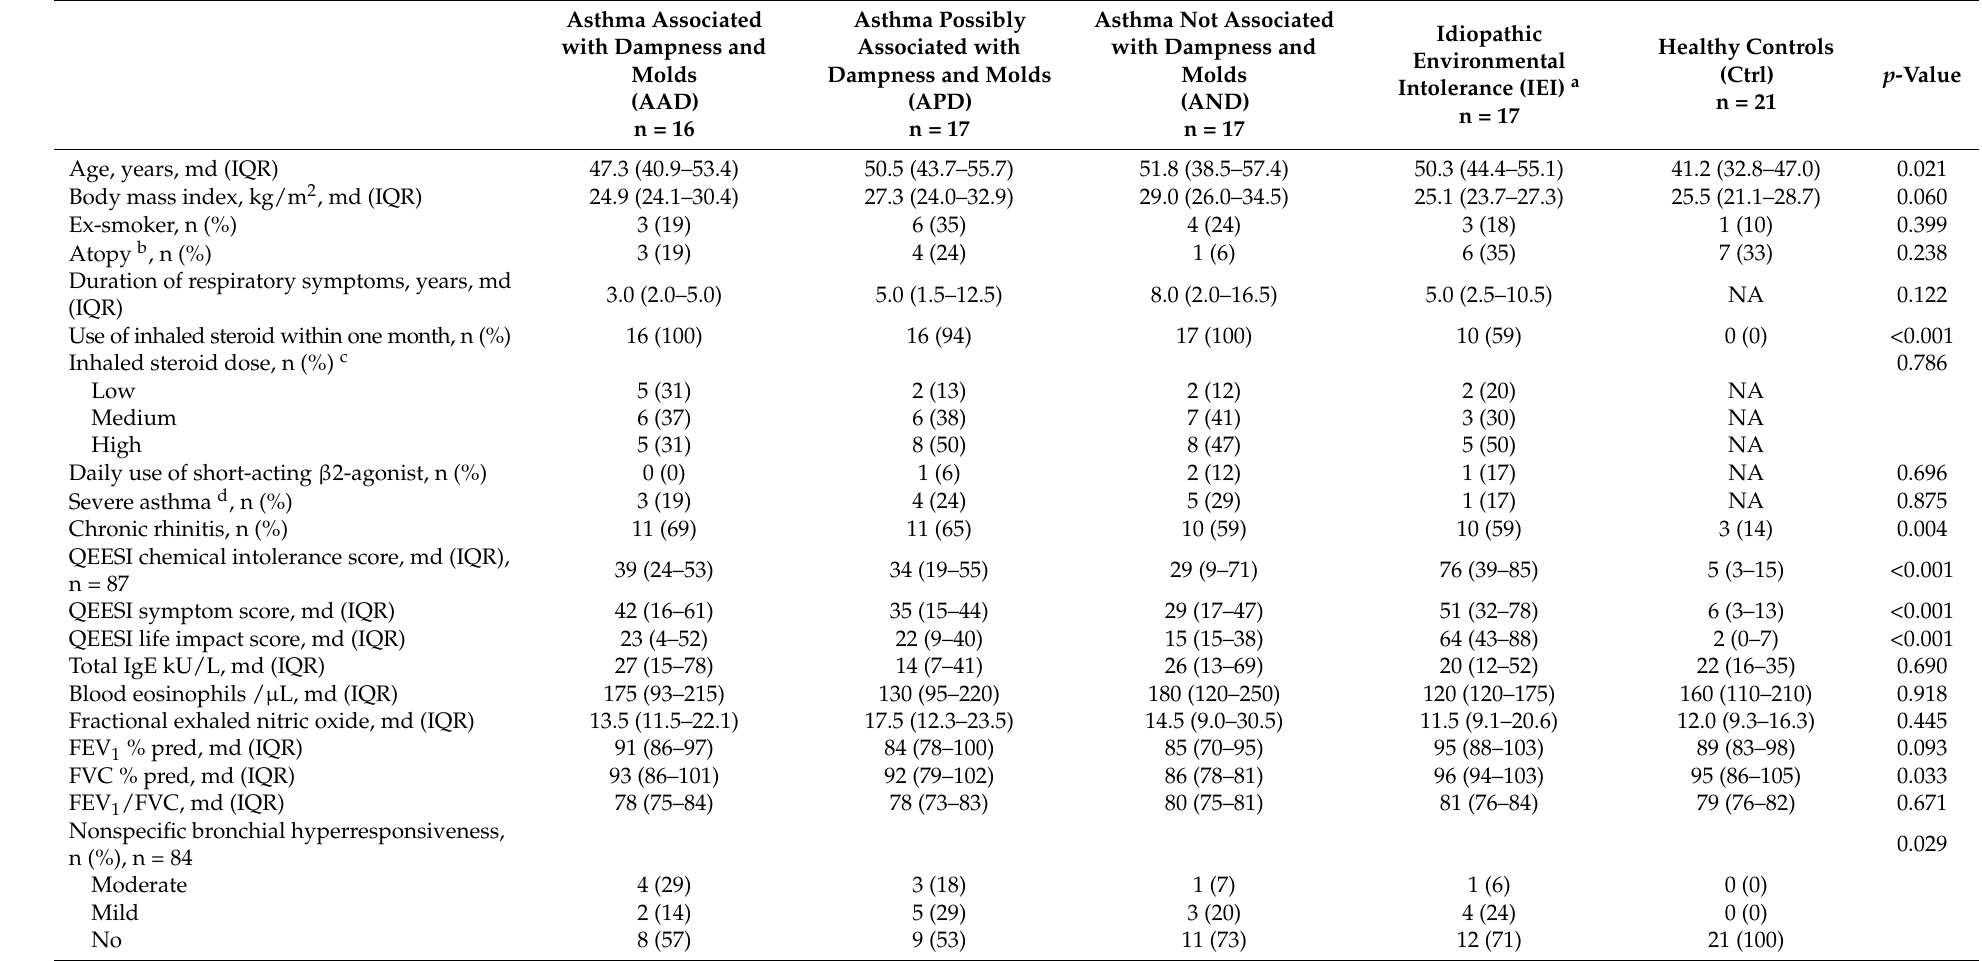
Table 1. Demographic and clinical characteristics during the sample collection of the study subjects. All subjects were nonsmoking